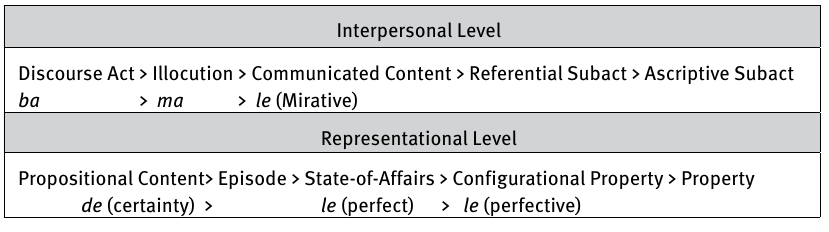
Figure 3. SF le at the Interpersonal and Representational